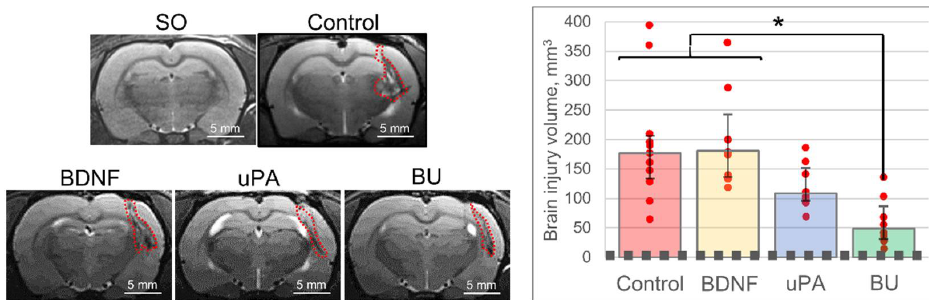
Figure 2. The results of magnetic resonance imaging of brains 11 days following the intracerebral hemorrhage. On the images, the dashed red line corresponds to the volume of the brain lesion focus in sham-operated (SO) animals. Red dots on the diagram correspond to the result of individual measurements. The data are presented as the median (25%; 75%). *—H (3, 28) = 16.424, p = 0.001. BDNF, brain-derived neurotrophic factor; BU, BDNF + uPA; uPA, urokinase-type plasminogen activator.